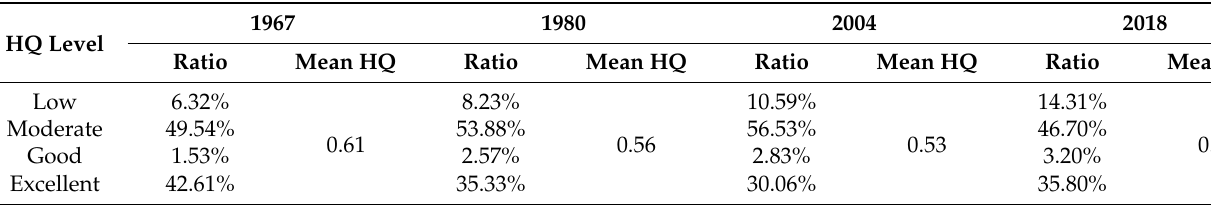
Table 8. Ratio of each HQ level during 1967–2018.